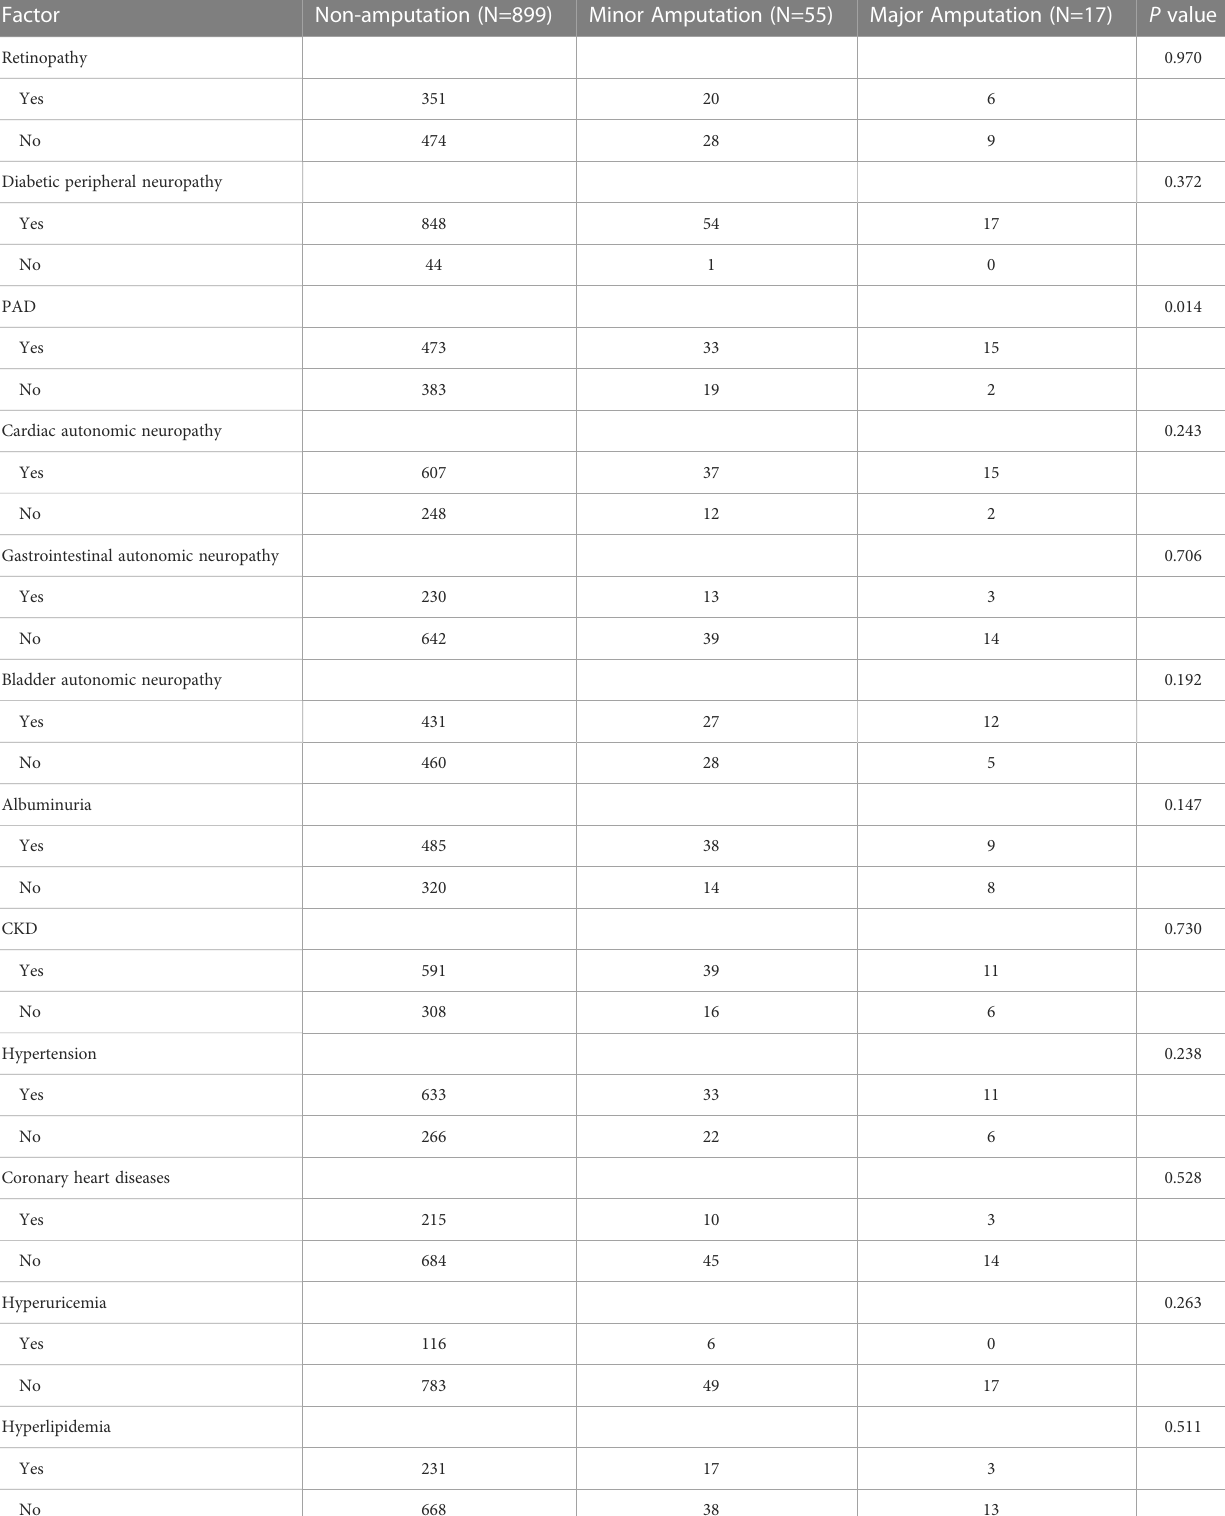
Values are presented as number. PAD, peripheral arterial disease. CKD, chronic kidney